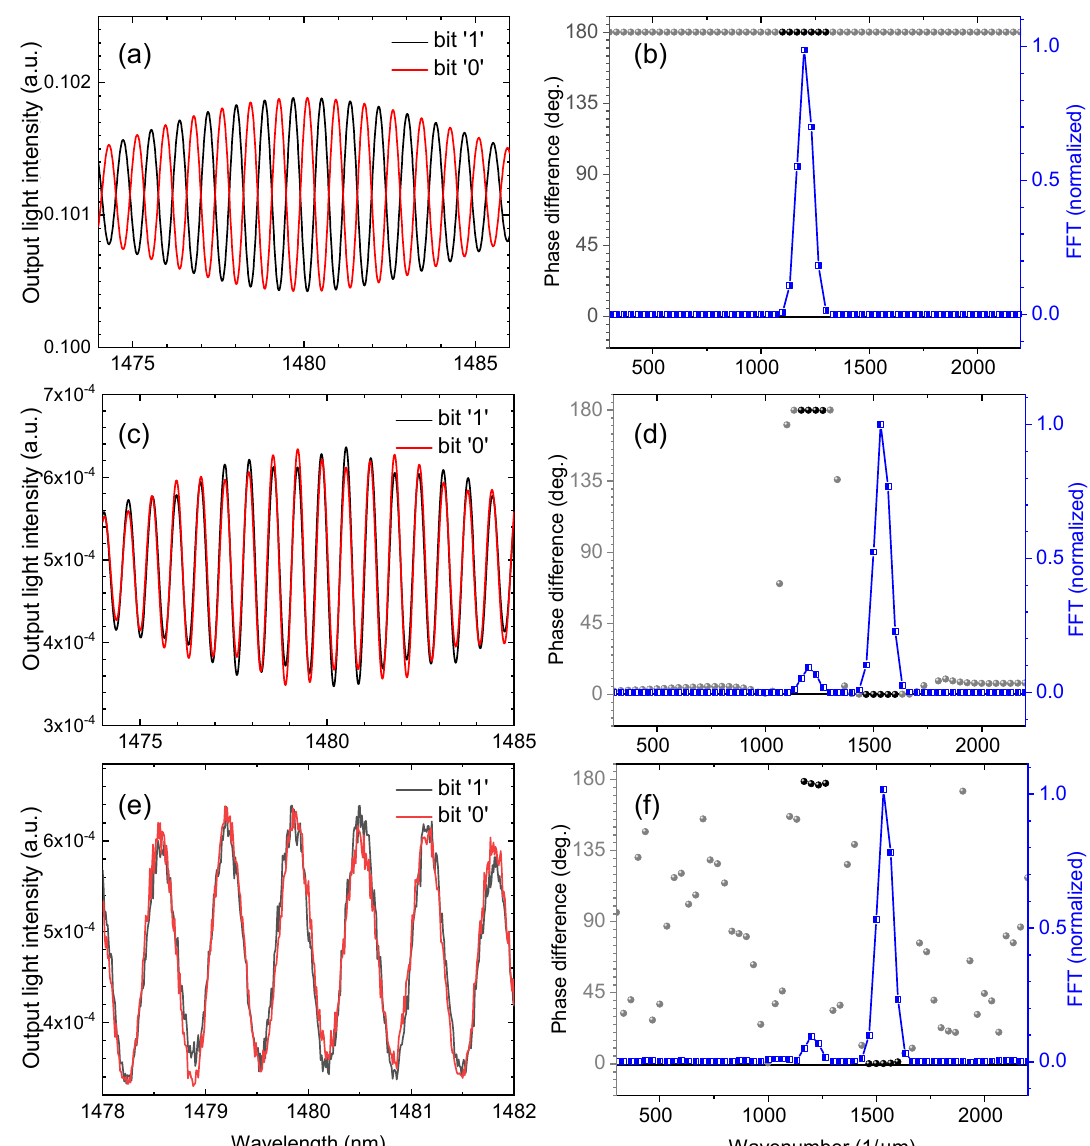
Figure 2. ( a , c , e ) Output light intensity vs. wavelength plots for standard, reduced-performance, and noisy reduced-performance devices (see Tables 2 and 3), The light intensities are shown in arbitrary units and is normalized assuming initial intensity ( I 0 ) is 1. ( b , d , f ) In blue, Fourier transformations of the intensity vs. wavelength plots are shown. The normalization is done assuming the highest intensity Fourier peak has amplitude 1. In black, the phase differences between the memory bit “1” and “0” are shown for each wavenumber. The data-points which correspond to a Fourier peak are shown in black while the rest is shown in grey. This is done for guidance to eye for separation of statistically significant result (black) and fitting procedure noise